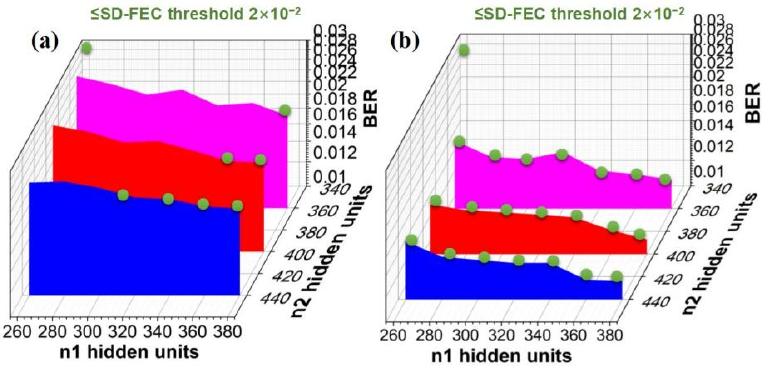
Figure 9. The BER performance of 4 Gbaud PS-16QAM signals with an optical input power of 9 dBm vs. the neuron cells n 1 in hidden layer 1 and those n 2 in hidden layer 2 by employing ( a ) CVNN classifier, ( b ) CVNN classifier combined with ROS. Table 1. Network parameters of various CVNN schemes.